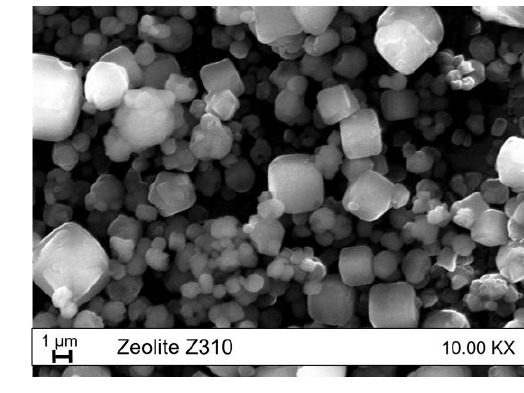
Figure 3. SEM images of zeolite 13X and Z310.